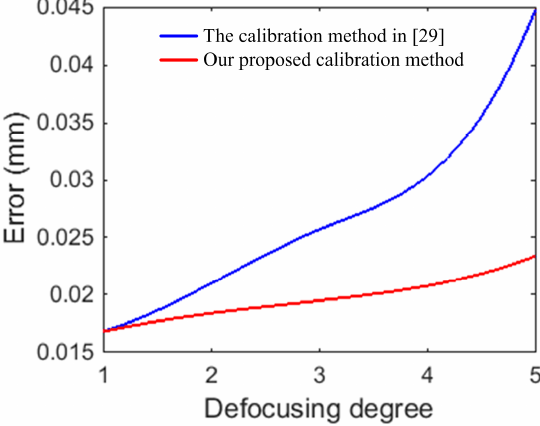
Figure 18. Measurement error of plane under different defocusing degrees using our proposed calibration method and the calibration method in [29].